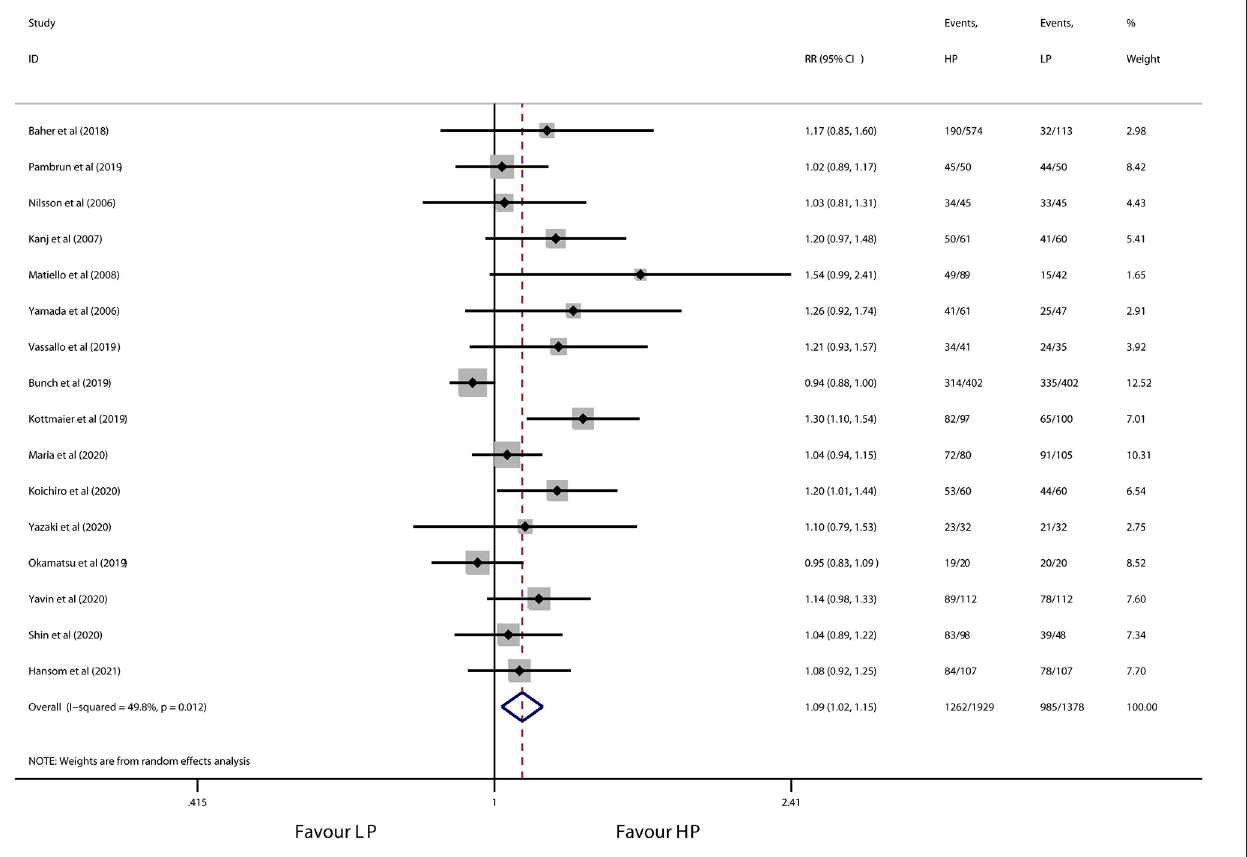
FIGURE 2 | Forest plot of AF/atrial tachycardia-free survival for high-power ablation vs. conventional-power ablation.